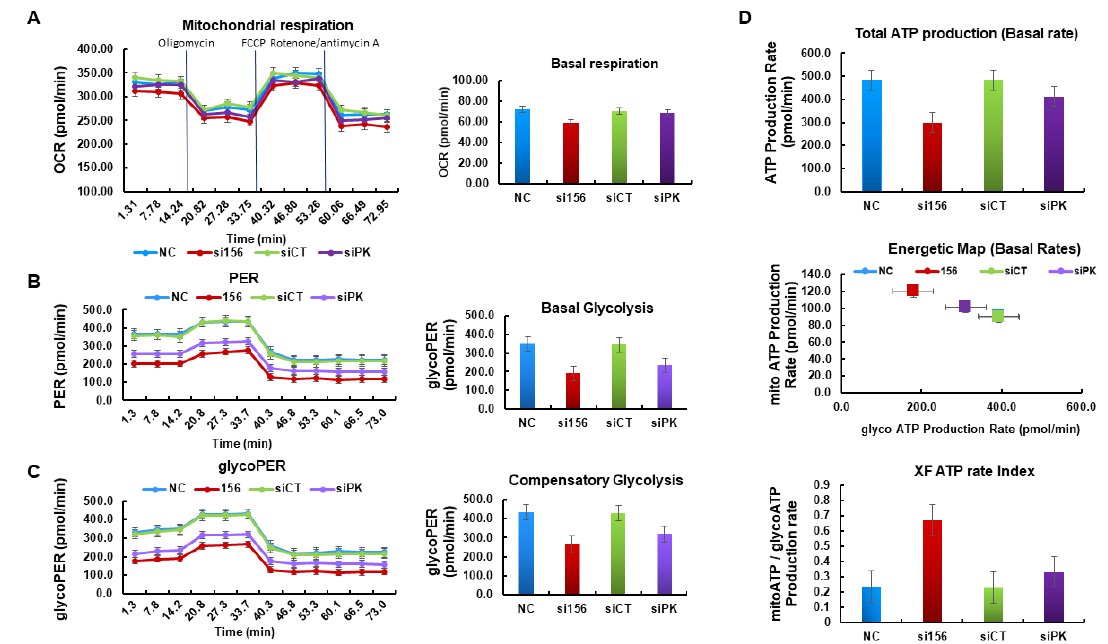
Figure 8. Pyruvate kinase M2 isoform (PKM2) silencing attenuates glycolysis in 786-O cells. ( A ) No significant changes were observed in oxygen consumption rate (OCR) after PKM2 expression knockdown. PKM2 knockdown also inhibited the basal respiration. ( B ) Proton efflux rate (PER) and basal glycolysis decreased after PKM2 expression knockdown by si156. ( C ) Proton efflux rate by glycolysis (glycoPER) and compensatory glycolysis decreased after PKM2 expression knockdown. ( D ) PKM2 knockdown significantly decreased total ATP production rate but increased the rate of mitoATP/glycoATP production.